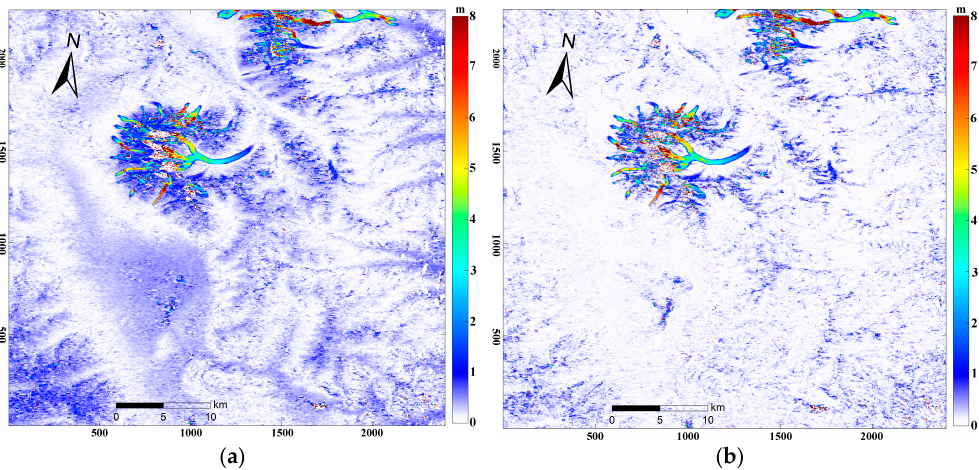
Figure 6. Comparison between the ice motion fields in the coordinates composed by the slant-range and azimuth ( a ) before and ( b ) after the topographic effect compensation.